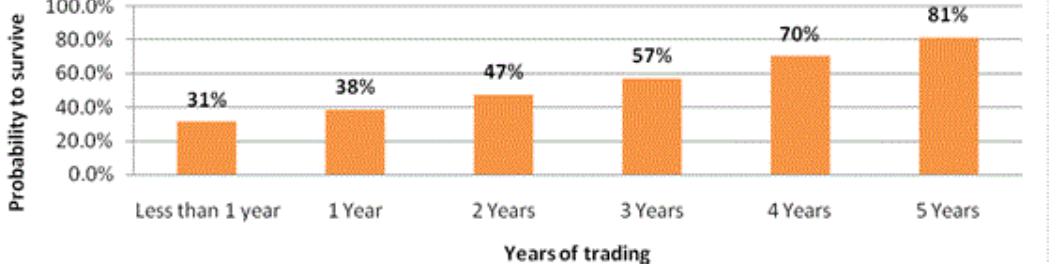
Figure 1: Age of the SME and probability of surviving for seven or more years (Source: Adapted from Knaup & Piazza,